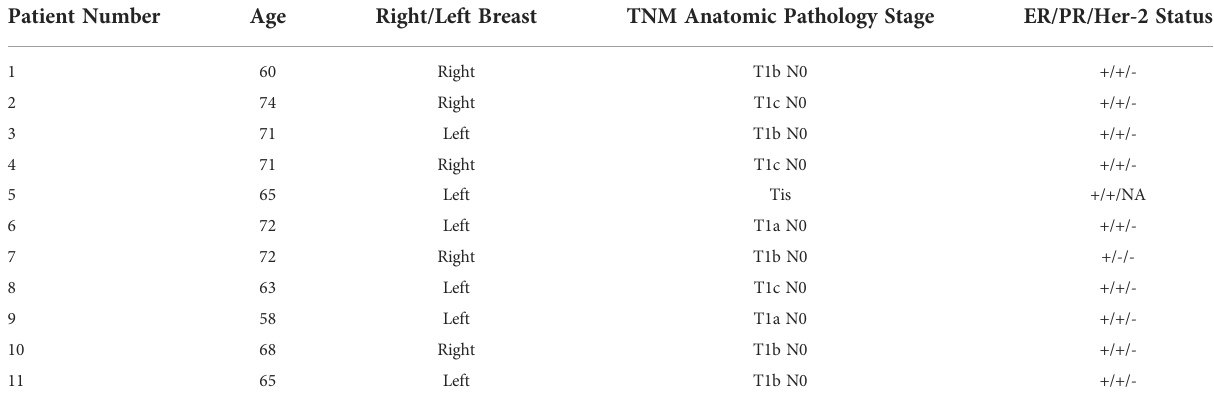
TABLE 1 Patients Characteristics – (NA: Not applicable, ER: Estrogen Receptor, PR: Progesterone Receptor). Patient